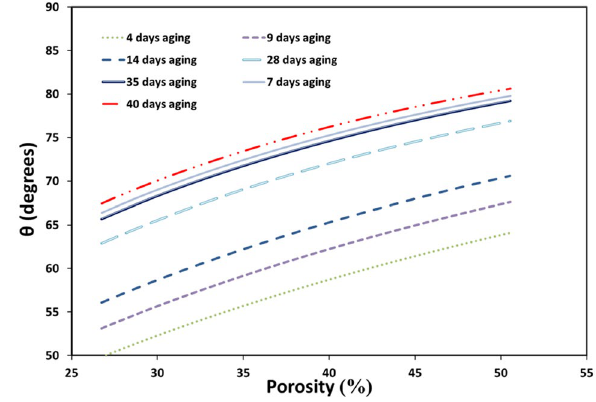
Fig. 10 Cumulative distribution of the calculated contact angle at aging times of 10, 20 and 40 days and displacement temperatures of 45 ºC and 90 ºC for the Rørdal